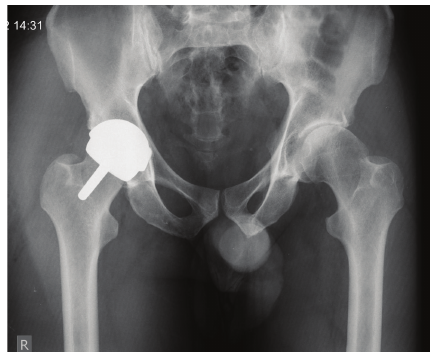
Figure 1: Postoperative radiograph after right Birmingham Hip Resurfacing. Left hip demonstrates features consistent with cam type femoroacetabular impingement and secondary osteoarthritis.